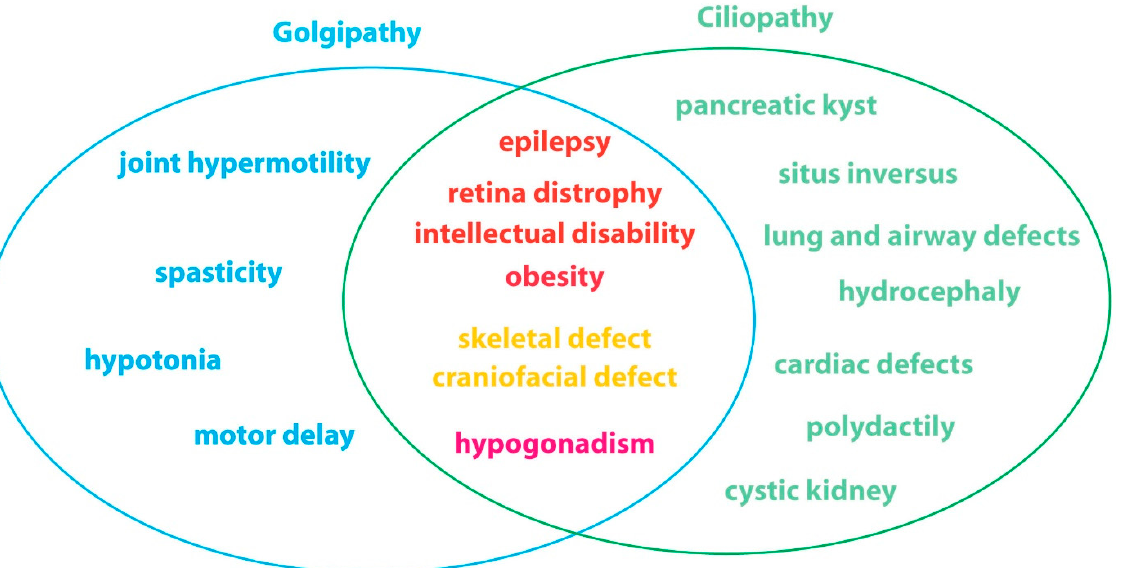
Figure 3. Clinical features of Golgipathies and ciliopathies. Whereas some defects are specific tor one disease class (in blue for Golgipathy and in green for ciliopathy), some are common and concern alterations in the central nervous system (in red, including obesity that has been described to be caused by hyperphagia), the skeleton (in orange) and the gonad (in pink).